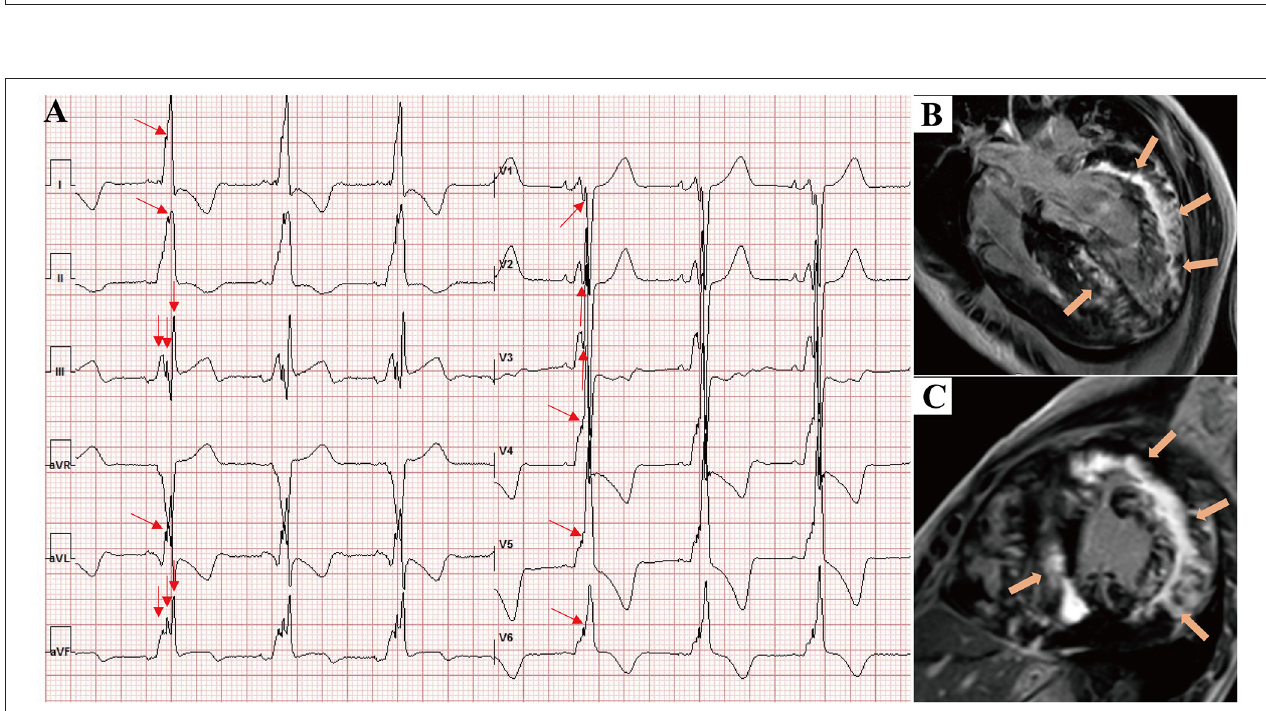
FIGURE 5 | A 17-year-old male presented with chest tightness, shortness of breath, and syncope and was genetically diagnosed with Danon disease (mutation site: c.35C > A). (A) f-QRS was found in 12 leads. Notched R/S patterns (single red arrows) were found in the I, II, aVL, and V1–V6 leads. The fragmented QRS pattern was found in III and aVF leads (double red arrows), and the total f-QRS score was 15. (B) Four-chamber view and (C) short-axis view of LGE images on CMR showed the extensive fibrosis/scarring in the lateral wall of LV and patchy fibrosis in the septum (orange arrows). Global LV LGE% was 36.7%. LGE, late gadolinium enhancement.